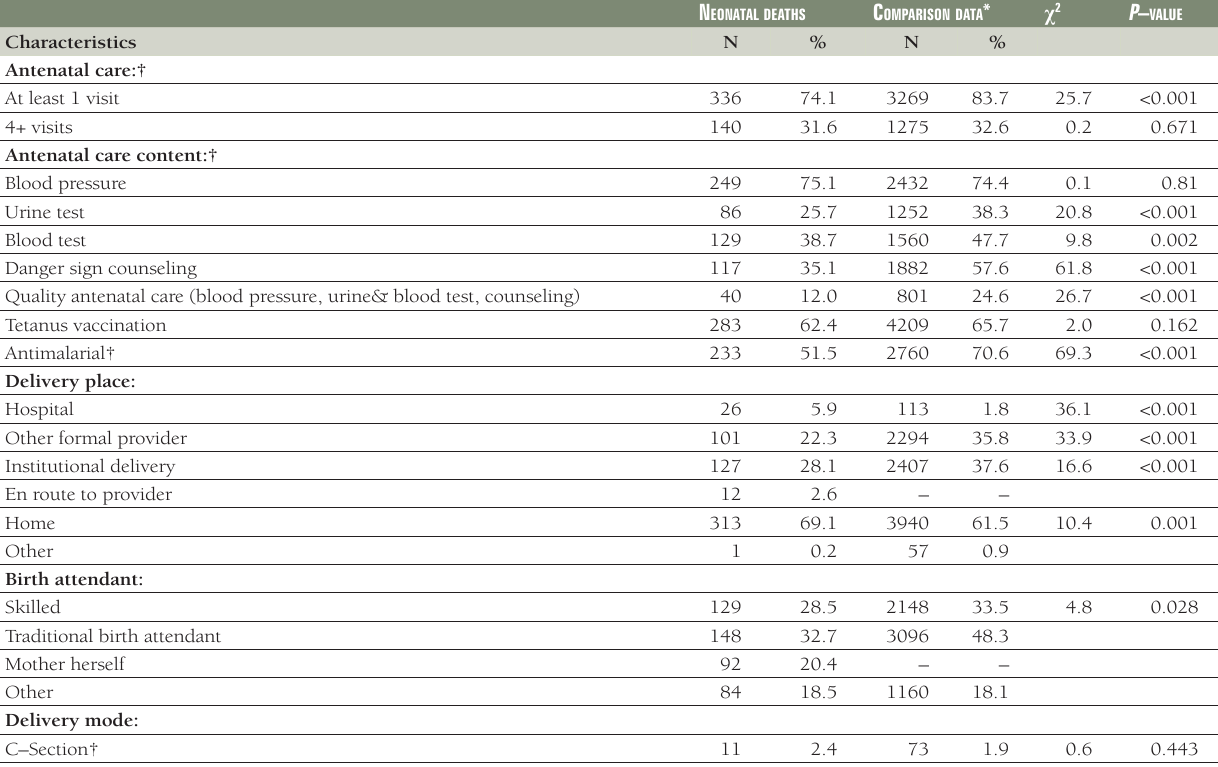
Table 2. Comparison of antenatal and delivery care indicators for 453 neonatal deaths with those of the general population, Niger,